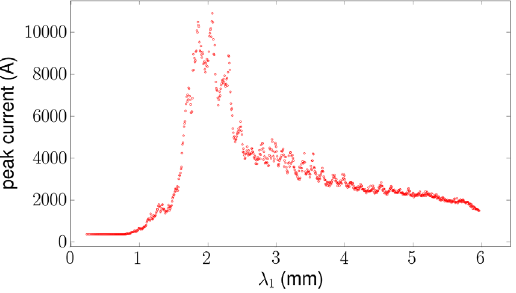
FIG. 10. Maximum peak current as a function of the funda- mental-mode wavelength λ 1 . The observed noise comes from numerical errors in precisely determining the value of the axial position where the peak current is maximized. These simulations are carried with the beam parameters summarized in Table I L -band column but for a DLW structure with inner radius a ¼ 650 μ m. The fundamental-mode wavelength is varied by changing the structure outer radius b .